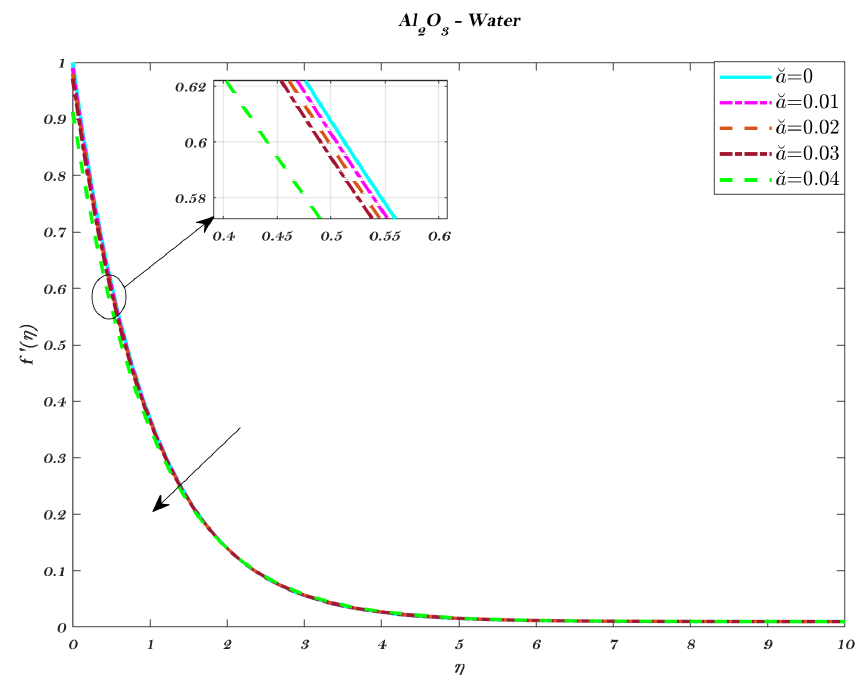
Figure 8. The influence of the slip parameter ˘ a against η on the velocity profile with ϕ = 3%, (cid:101) = 0.01 and R = 1.